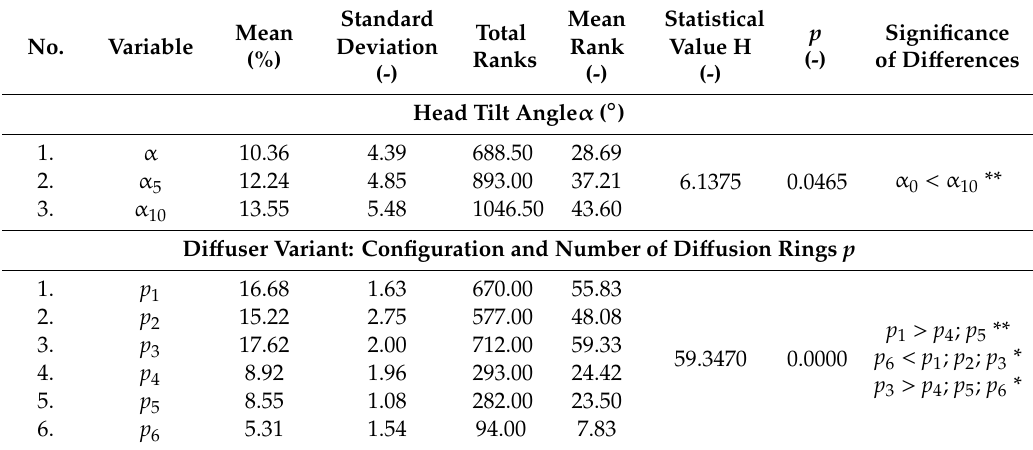
Table 1. The analysis of variance for the coe ffi cient of variation ( CV ) in transverse oat seeds sowing evenness depending on the angle of the distribution head deviation from the vertical position α ( ◦ ) and the di ff user variant p (the configuration and number of di ff usion